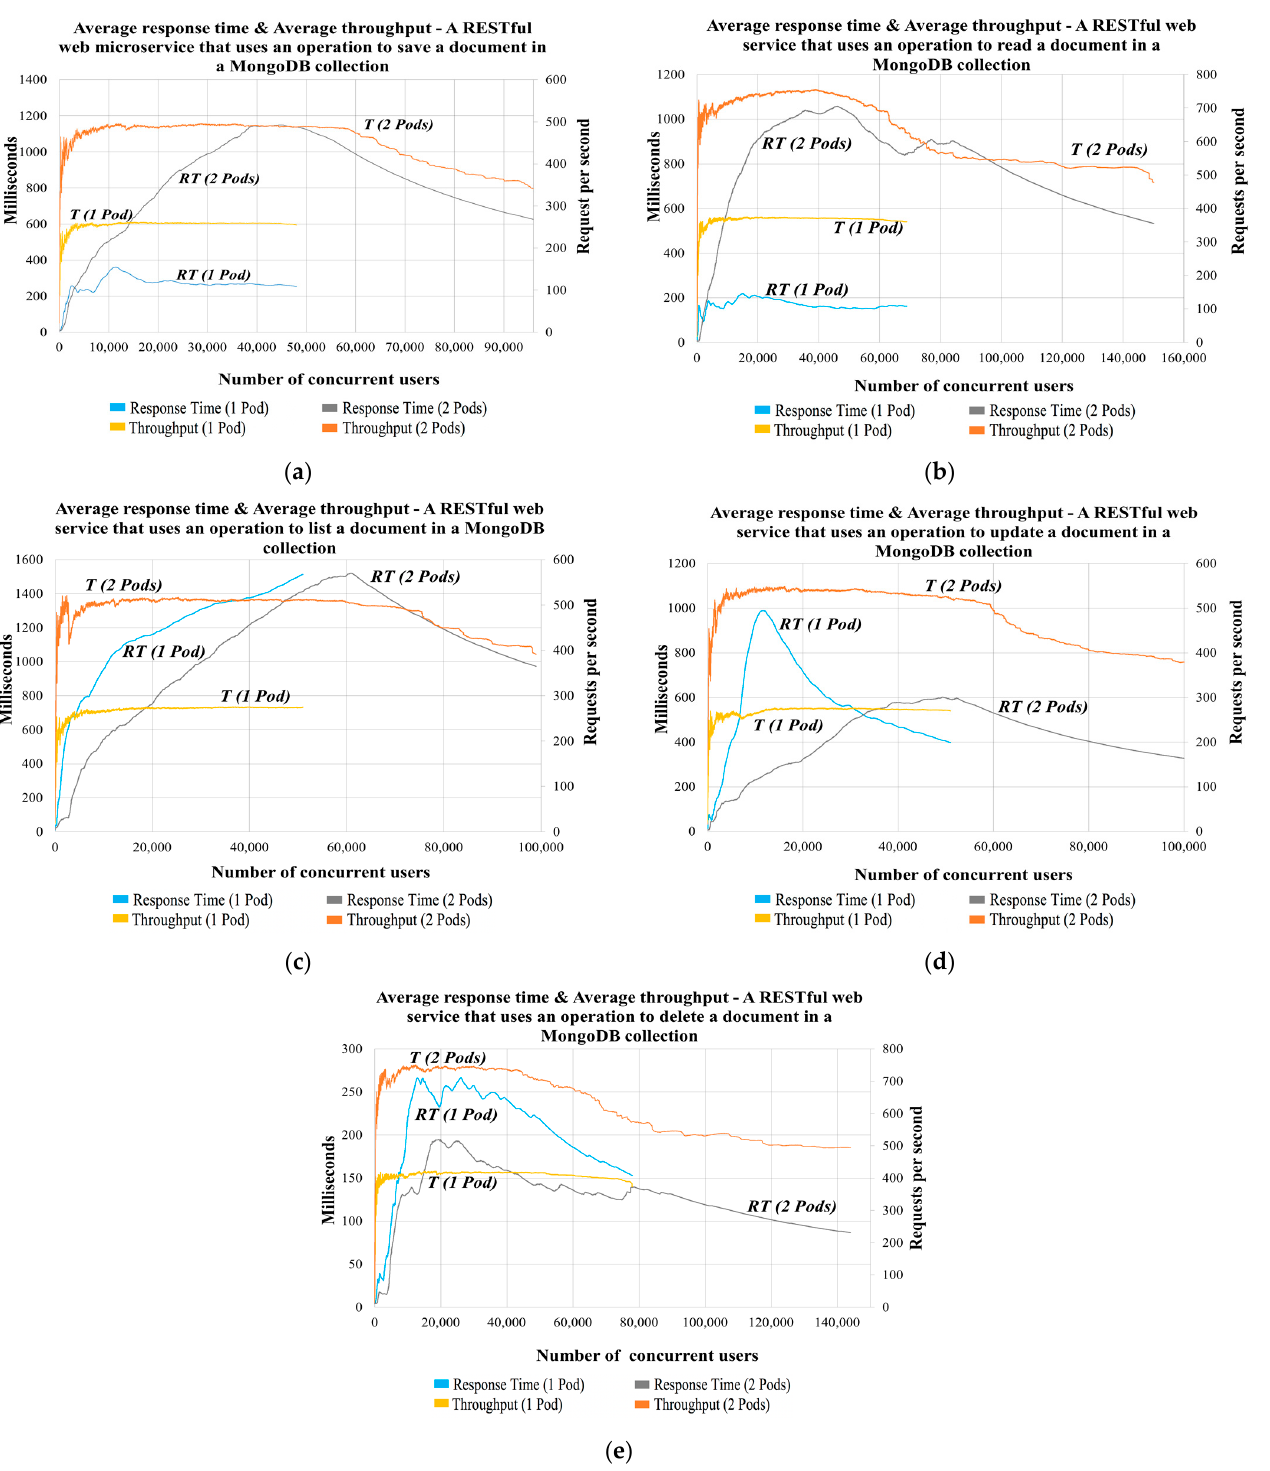
Figure 15. Scalability based on the increment of 1 and 2 pods of core services on a K8s cluster with different types of operations: ( a ) Saving individual records. ( b ) Reading individual records. ( c ) Reading multiple records. ( d ) Individual update of records. ( e ) Individual deletion of records.